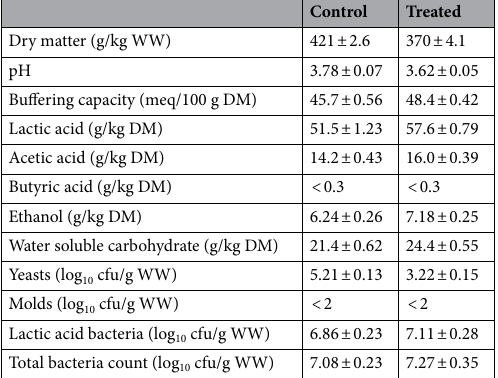
Table 1. Chemical and microbial analyses of the two silages at sampling, not treated or treated with a biological additive. Data are means ± SE of n = 3 replicates; WW, wet weight; DM, dry matter; cfu, colony- forming units.